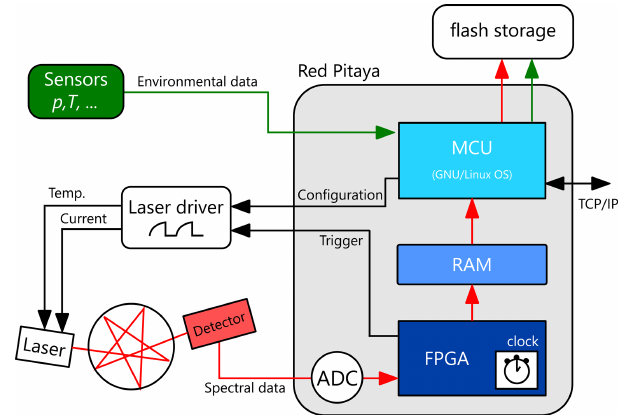
Figure 5. Schematics of data acquisition and transfer within the in- strument. To acquire spectral data, the laser driver is triggered by the FPGA and generates current pulses of predefined length, amplitude, and shape. A multitude of additional sensors both for spectroscopic as well as diagnostic purposes (green) are regularly read out. The internal clock of the FPGA synchronizes the different